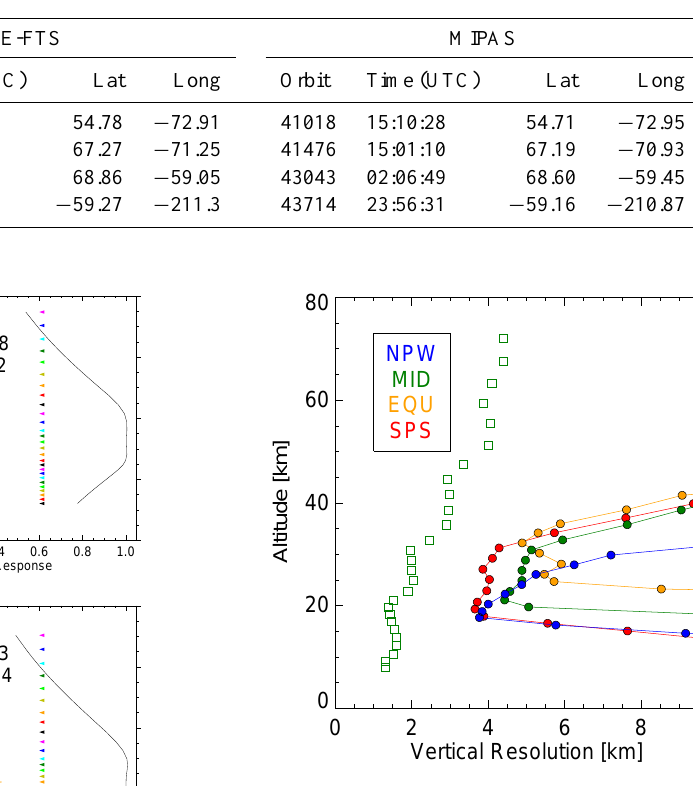
Figure 6. Vertical resolution as a function of altitude of the four re- trievals shown in Fig. 4. The open squares show the vertical spacing of the retrieval grid (which is also the measurement tangent height spacing) for the midlatitude profile; for the other profiles the pattern is the same but shifted up or down by a few kilometres. The reso- lution at each altitude is defined as the ratio of the diagonal of the averaging kernel matrix (Fig. 5) to the grid spacing, which is only meaningful where the averaging kernels have distinct peaks at the tangent point. The MIPAS field of view is approximately 3km high, which sets a practical limit on the resolution obtainable at lower al- titudes when the limb is